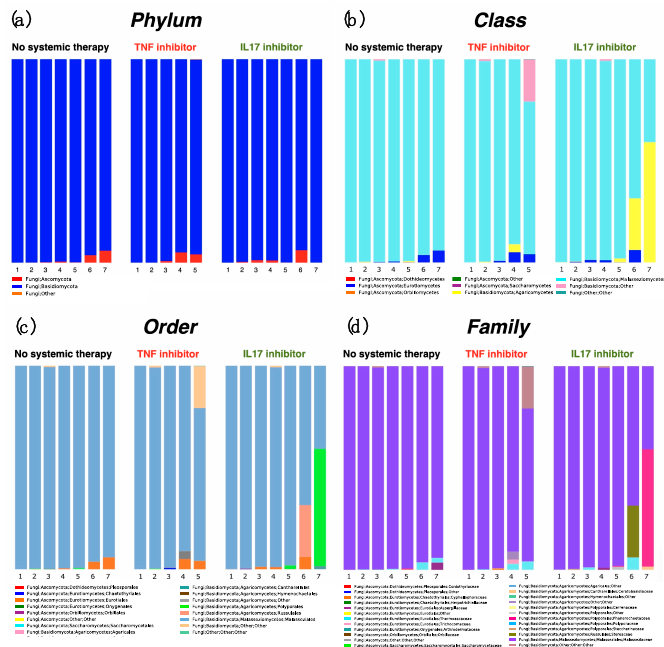
Figure 1. Bar chart showing the relative distribution of fungi at the phylum level ( a ), class level ( b ), order level ( c ), and family level ( d ). Samples were obtained from the post-auricular area of psoriasis patients not receiving systemic therapy (no-therapy group, n = 7) and from those treated with TNF inhibitors (TNFi group, n = 5) and IL-17 inhibitors (IL-17i group, n =